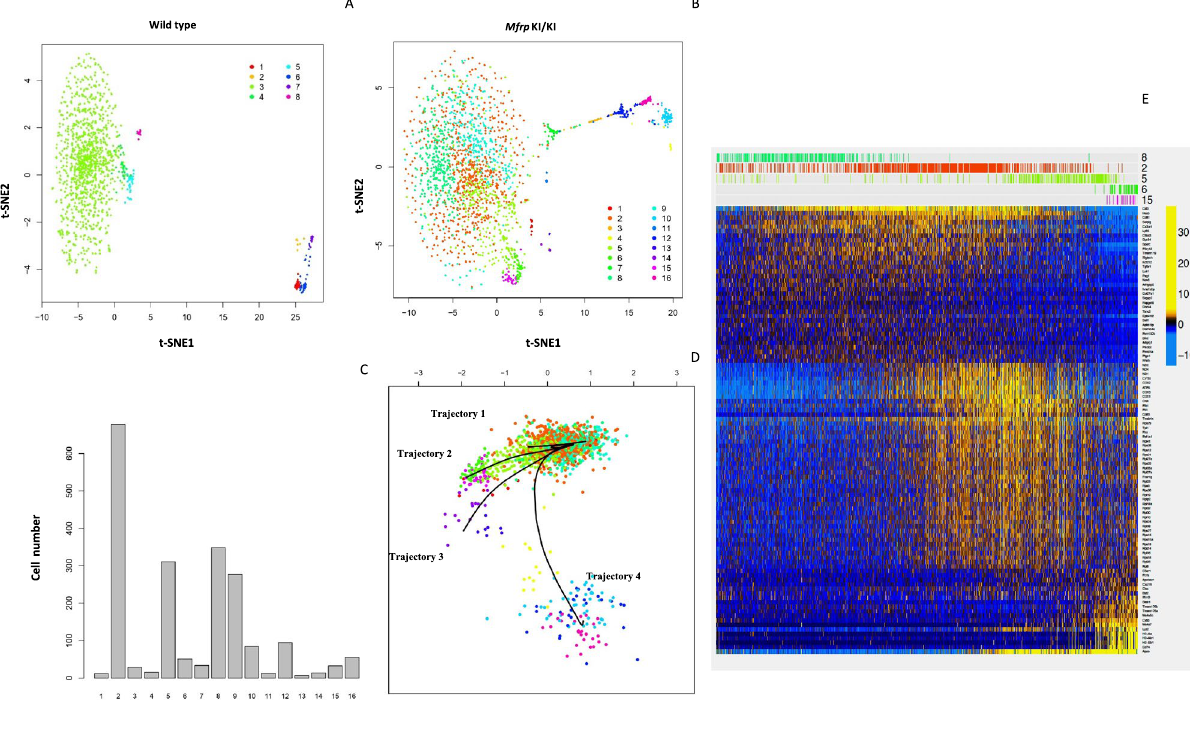
Figure 7. Separate analysis of Microglia from Mfrp KI /KI and WT mouse retina and trajectory analysis. Microglia from Mfrp KI /KI and WT mouse retina were clustered separately ( A ) tSNE plot of microglia from WT mouse retina, ( B ) tSNE plot of microglia from Mfrp KI /KI mouse retina. ( C ) Histogram of clusters generated from Mfrp KI /KI retinal microglia. ( D ) Trajectory analysis of Mfrp KI /KI microglia demonstrating four trajectories 1 to 4, Trajectory 1: 8 2 5 4 10 16 12, Trajectory 2: 8 2 9 1 14 13, Trajectory 3: 8 2 5 6 15, Trajectory 4: 8 2 7. ( E ) Heat map, generated by “pheatmap” package in R program, shows gradual changes in gene expression beginning with cluster 8 and ending in cluster 15 in Trajectory